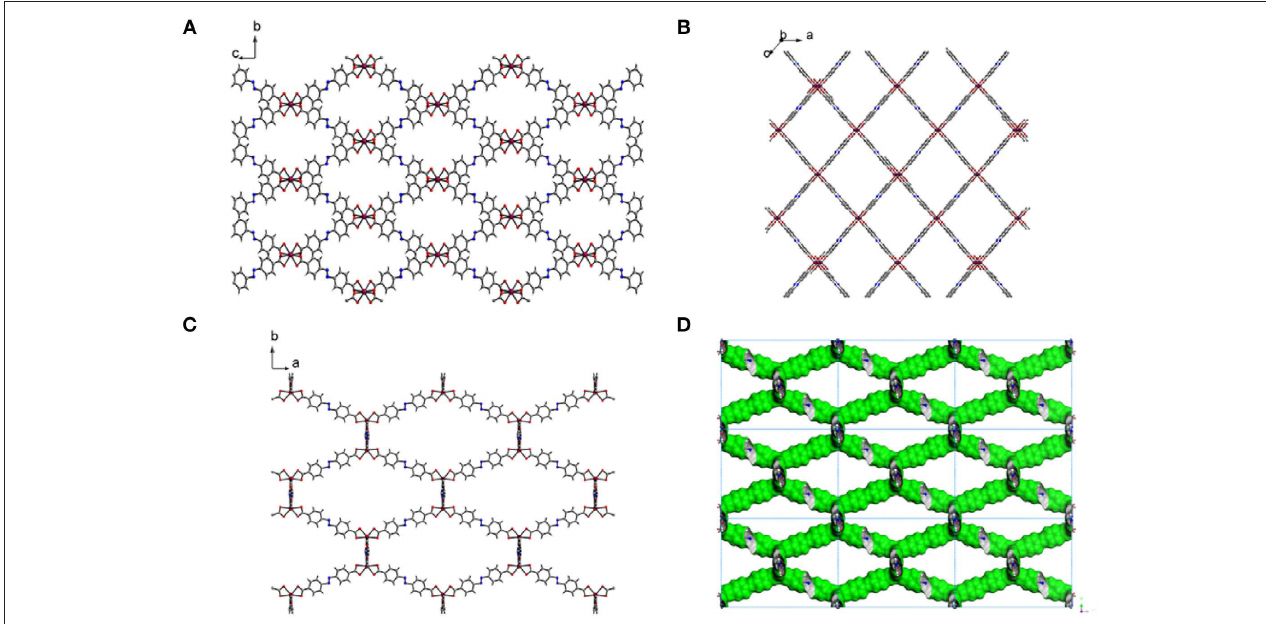
FIGURE 3 | 3D structure of [In(ABDC) 2 ] − along the a -axis (A) , along the b -axis (B) , and along the c -axis (C) . The counter-cations (EMIM + ) and solvent molecules could not be refined. The color codes: indium, purple; carbon, gray; nitrogen, blue; oxygen, red; hydrogen, white. The Connolly surface of solvent-free I viewed down the c -axis, probed with a probe radius of 1.4 Å (D) . Nine unit cells are shown here. Green and gray surfaces indicate outer and inner surfaces, respectively.